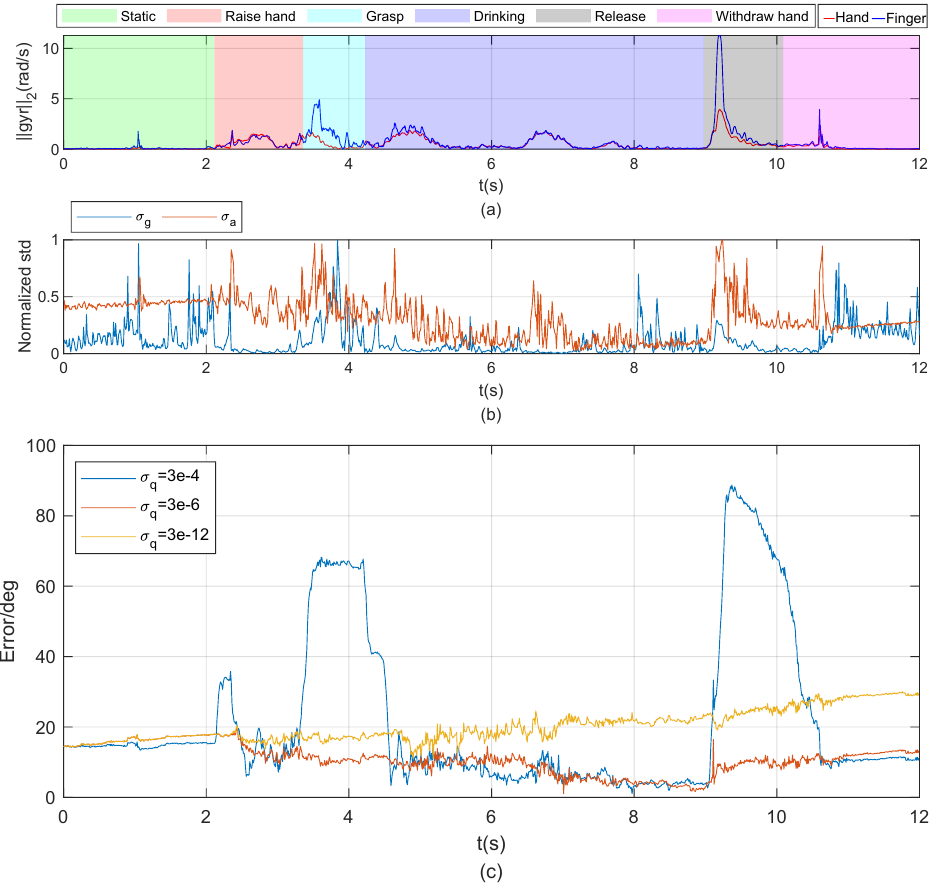
Figure A1. Relative orientation between the hand and thumb during the water-drinking process. Subfigure ( a ) shows the output norms of the two gyroscopes (on the hand and finger tip respectively). Subfigure ( b ) shows the normalized SDs σ a and σ g from Equations (18) and (21). Larger σ a and σ g mean larger measurement error. The EKF trusts the process model more and the measurement model less when σ a and σ g are larger. Subfigure ( c ) shows the estimated results with different SDs of the process model. The variance of process error Q was determined as σ p I 4